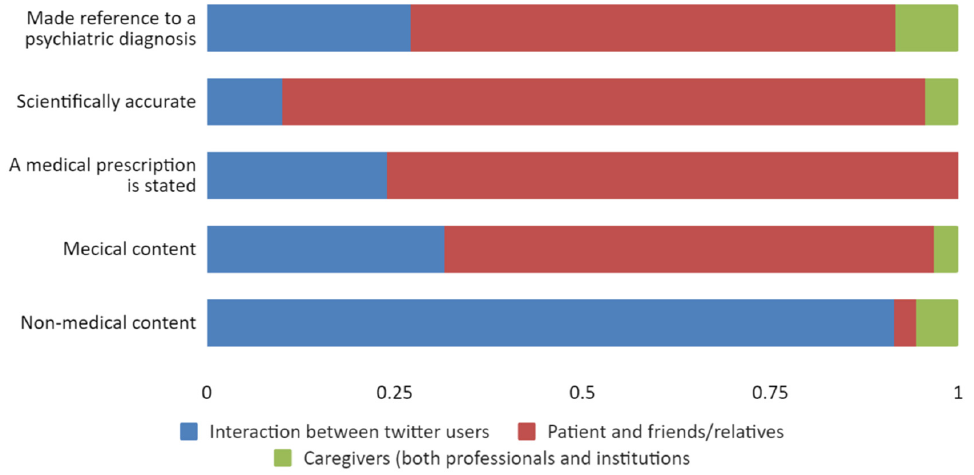
Figure 2. Proportion of type of user by considered aspects of tweets.